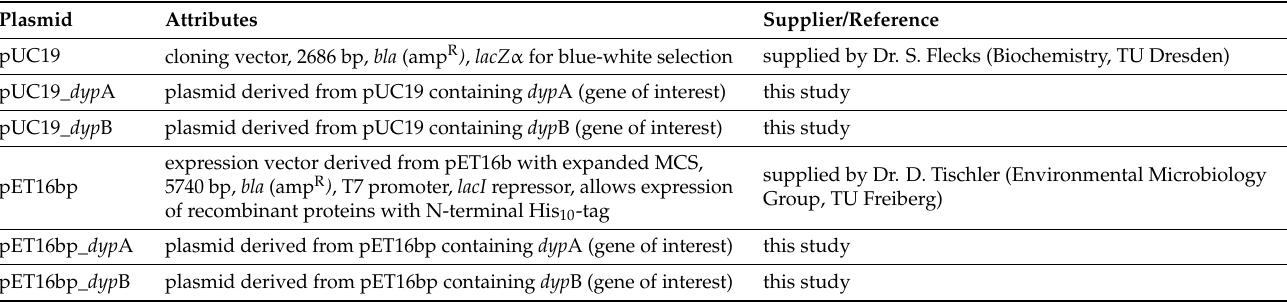
Table A2. Plasmids used in this study.